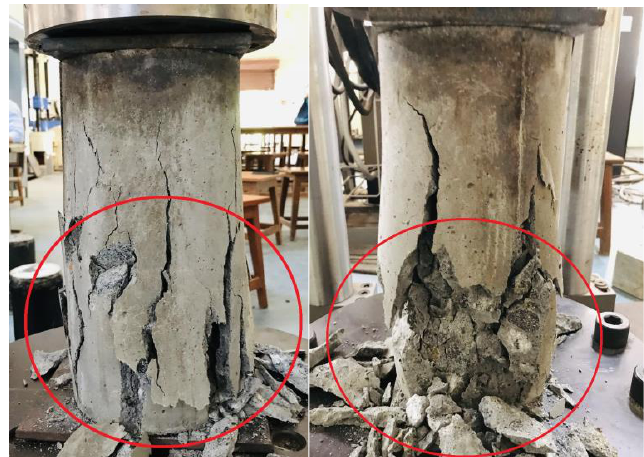
Figure 5. Failure patterns of unconfined specimens.